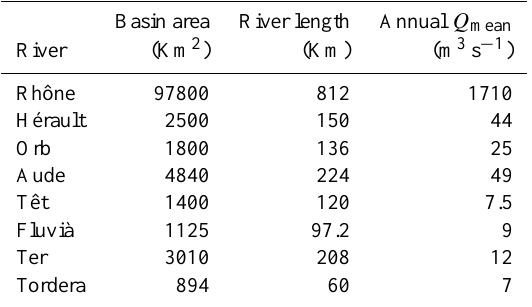
Table 1. Main characteristics of the studied river basins ordered from north to south.